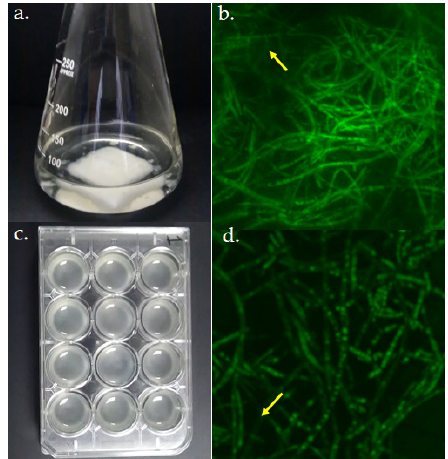
Figure 2. Biofilm models of A. fumigatus LMB-35Aa grown on ( a ) polyester and ( c ) polystyrene. Biofilm structure was analyzed by CSLM at 72 h of growth. Average projections of stained biofilms 40× images on ( b ) polyester and ( d ) polystyrene are shown. Green fluorescence depicts fungal viable cells; arrows indicate regions with the extracellular matrices of biofilms. When comparing the expression of virulence-related genes (Figure 3a,b), a similar expression J. Fungi 2020 , 6 , x FOR PEER REVIEW pattern was observed in both biofilm models with the exception of fumitremorgin biosynthesis ftmA gene, which was upregulated in the biofilms formed on the polyester cloth and downregulated in the biofilms formed on polystyrene, with respect to the planktonic cultures. On the other hand, a differential gene expression was observed when the biofilms were compared with planktonic cultures. According to Figure 3a, all the genes involved in the cell wall structure ( rho1 , ags1 , agd3 and glfA ) showed a lower expression level in biofilms, a pattern which was especially significant in the case of biofilms developed on polystyrene. This pattern was also observed in the case of the hydrophobin rodB gene. Conversely, invasin gene calA was significantly upregulated in both types of biofilms. With respect to ABC efflux transporters, genes mdr4 and atrF were predominantly upregulated in biofilm formed on polystyrene. In the opposite way, Figure 3b shows that the aspHs gene, which encodes for hemolysin, and ftmA , involved in mycotoxin biosynthesis, were upregulated only in biofilms on polyester, while gliZ and aspF1 genes, encoding proteins involved in secondary metabolism, exhibited a significant downregulation in biofilms formed on polystyrene. With respect to medA , involved in cell adhesion and biofilm formation, it had a slightly higher level of expression in the biofilms formed on polystyrene as compared with those formed on polyester, although in both cases these were not significant. Finally, with regard to regulator genes, rtfA was downregulated and the laeA gene, encoding for a secondary metabolism regulator, did not show any significant change when A. fumigatus formed biofilms.